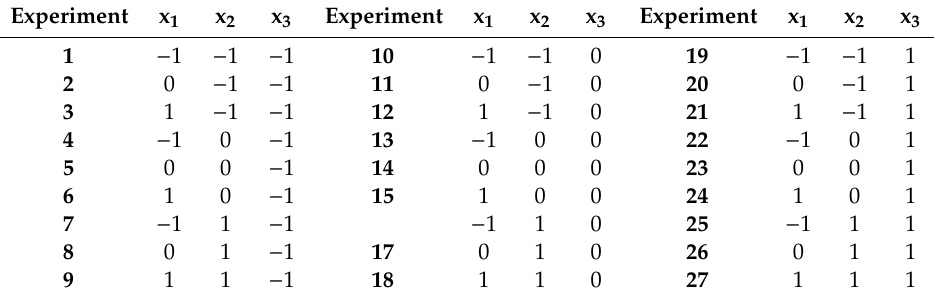
Table 4. Conditions of experiments performed in full factorial 3 3